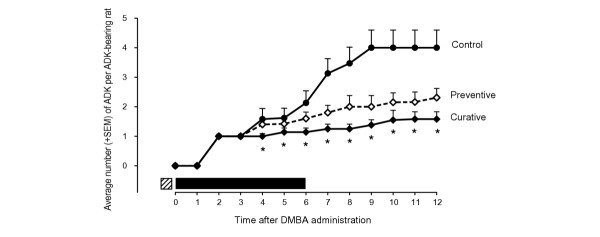
Average number (mean ± standard error of the mean) of mammary adenocarcinomas (ADKs) per ADK-bearing rat after daily administration of melatonin (10 mg/kg) for either 15 days before (preventive treatment; open diamonds) or 6 months after (curative treatment; filled diamonds) the administration of dimethylbenz [a]anthracene (DMBA). In both cases, the rats were followed up for 12 months after the administration of DMBA. Hatched bar, duration of preventive treatment; filled bar, duration of curative treatment. *P < 0.05 vs controls; **P < 0.01 vs controls.